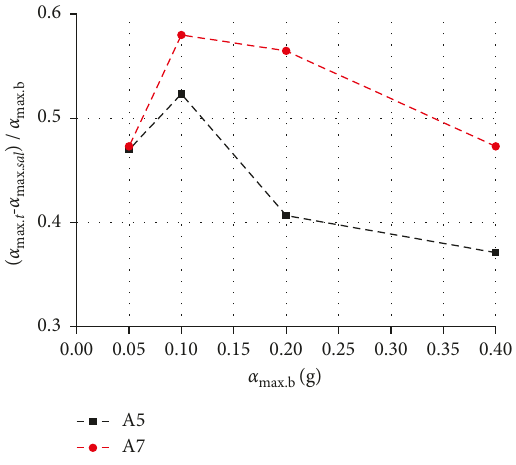
Figure 15: The SAL reduction